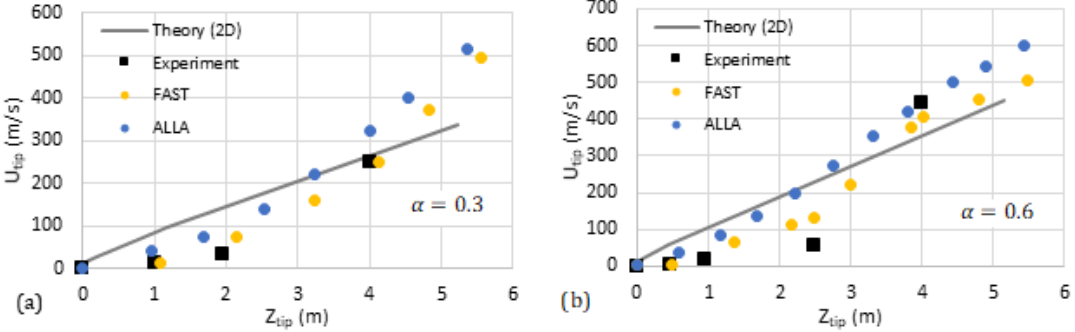
Figure 11. Comparison of our theoretical formulation with the experiments [31] and computational simulations [6] (FAST, yellow, and ALLA, blue). The flame tip velocity vs. its position for the blockage ratios α = 0.3 ( a ) and 0.6 ( b